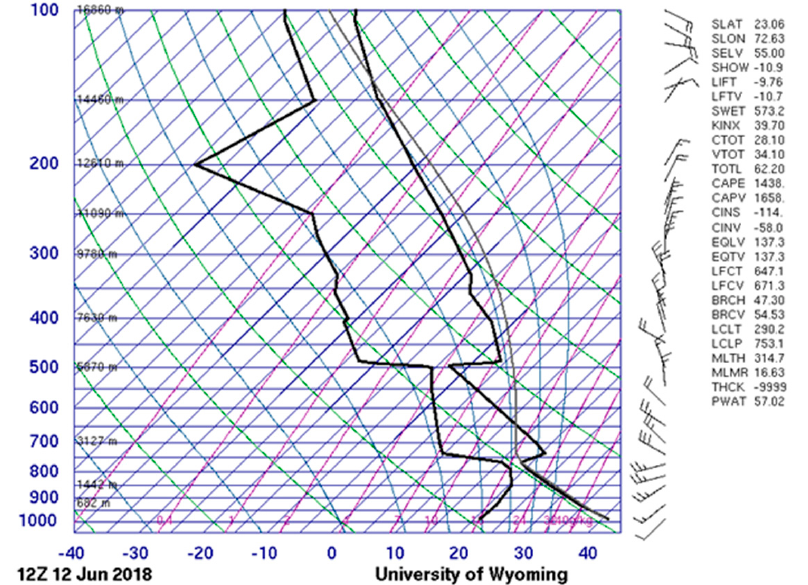
Figure 6. Atmospheric sounding observed at Ahamadabad, India at 1200 UTC on 12 June 2018 [30].